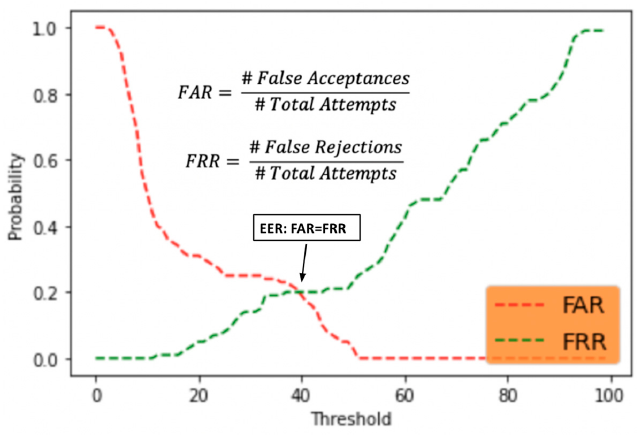
Figure 12. FAR and FRR curves for face mask facial recognition pipeline.